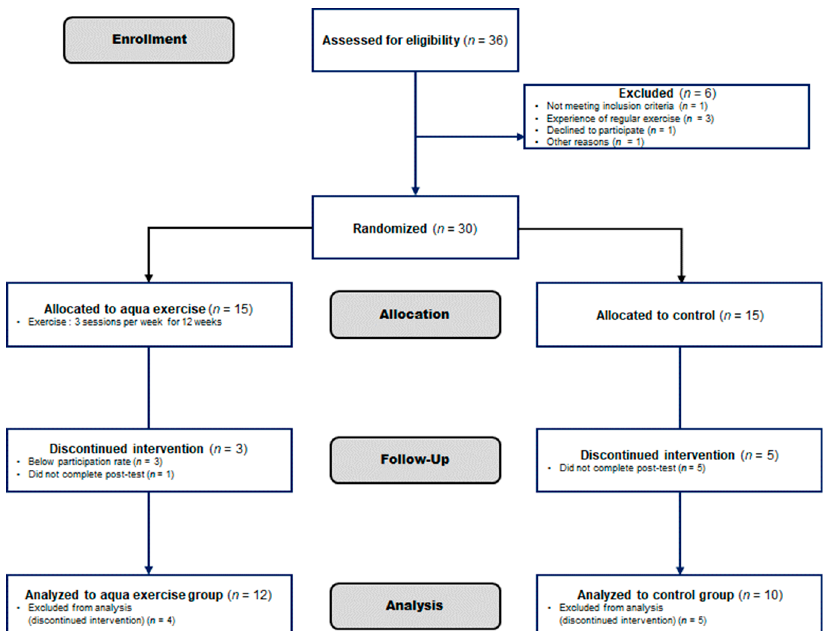
Figure 1. Study flow chart based on Consort 2010 Flow Chart Diagram. The first 36 elderly women were enrolled for our experiment, but 6 were excluded because they were not suitable for the study. Thirty participants were randomly assigned to the Aquatic exercise group and the Control group, and the final subjects were Aquatic exercise ( n = 12) vs. the Control group ( n =